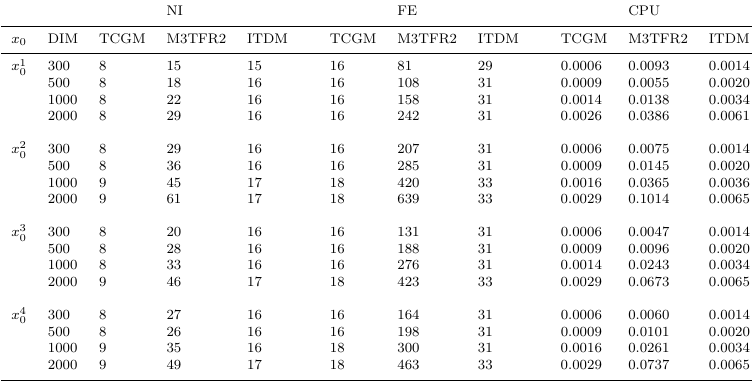
Table 3. Numerical results of Problem